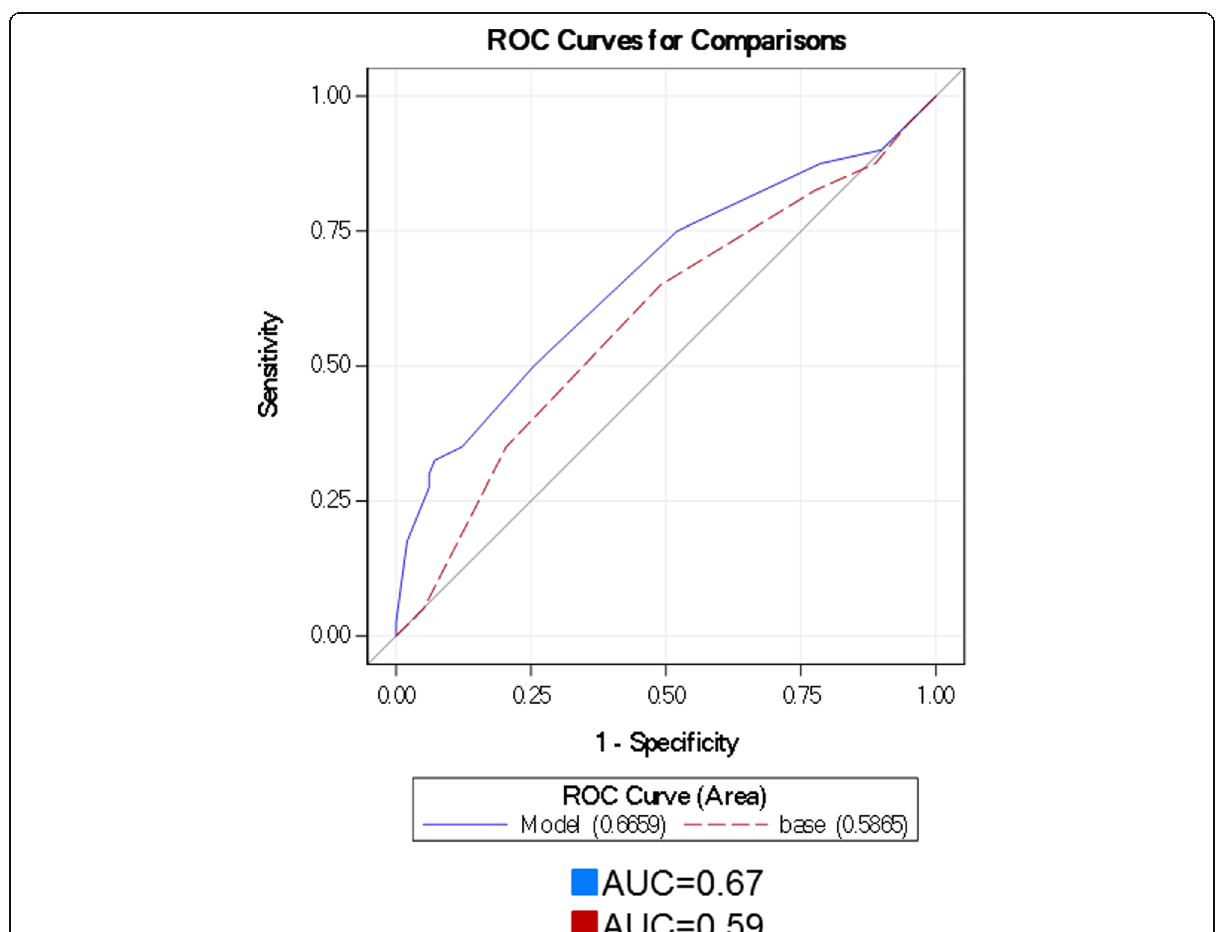
Fig. 3 AUC difference estimate, 0.08 (0.002, 0.16), p = 0.04. Abbreviations : AUC area under the curve, NRI net reclassification improvement, ROC